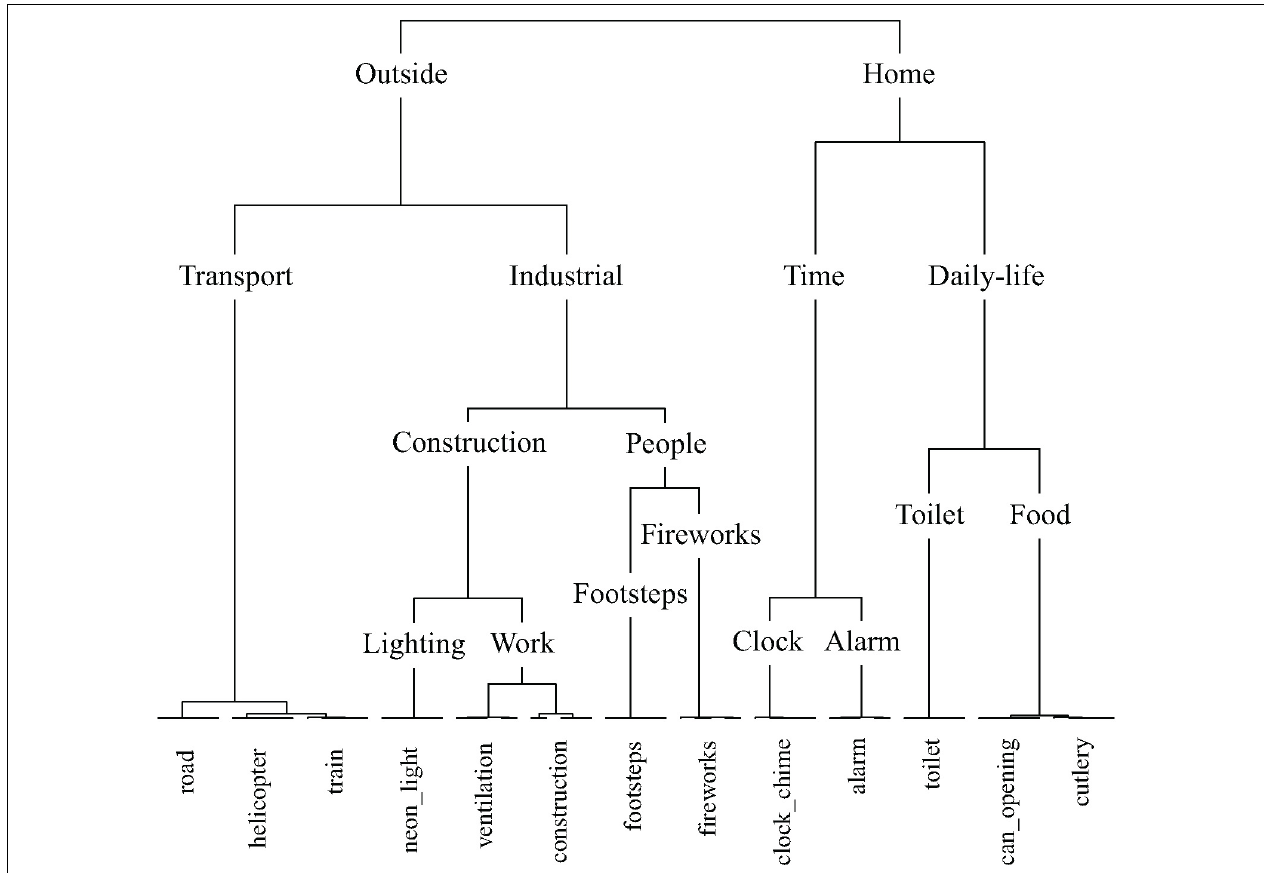
FIGURE 8 | The manmade taxonomy generated by hierarchical cluster analysis of the principal dimensions resulting from correspondence analysis. Note that five exemplars of each sound were used in this study. In all cases all five exemplars of each sound were categorized